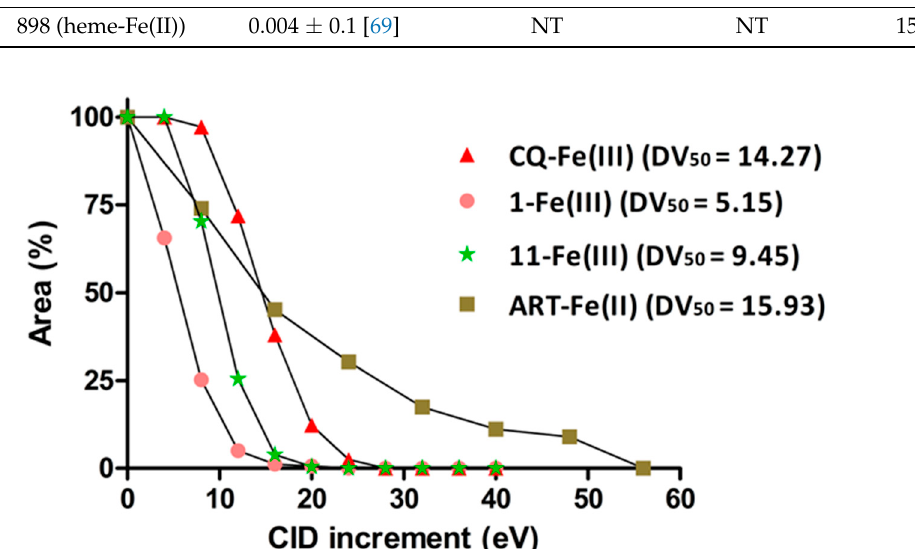
Figure 4. Dissociation curves for the more significant compounds isolated from P. coruscans compared with chloroquine (CQ) and artemisinin (ART). Table 2. Antiplasmodial activity, cytotoxicity, and dissociation voltage of isolated compounds. NT= not tested; NA = no adduct; CQ = Chloroquine; ART = Artemisinin. * Adduct not detected. Cpd = compounds. Selectivity index was calculated with CC 50 on AB943 Primary human fibroblast line cells and IC 50 for antiplasmodial activity.